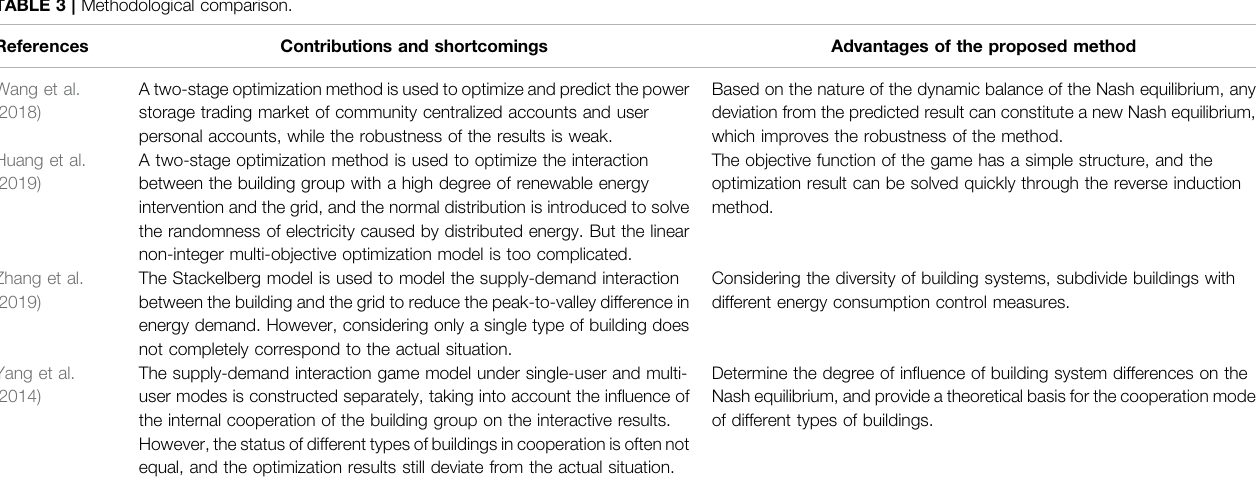
TABLE 3 | Methodological